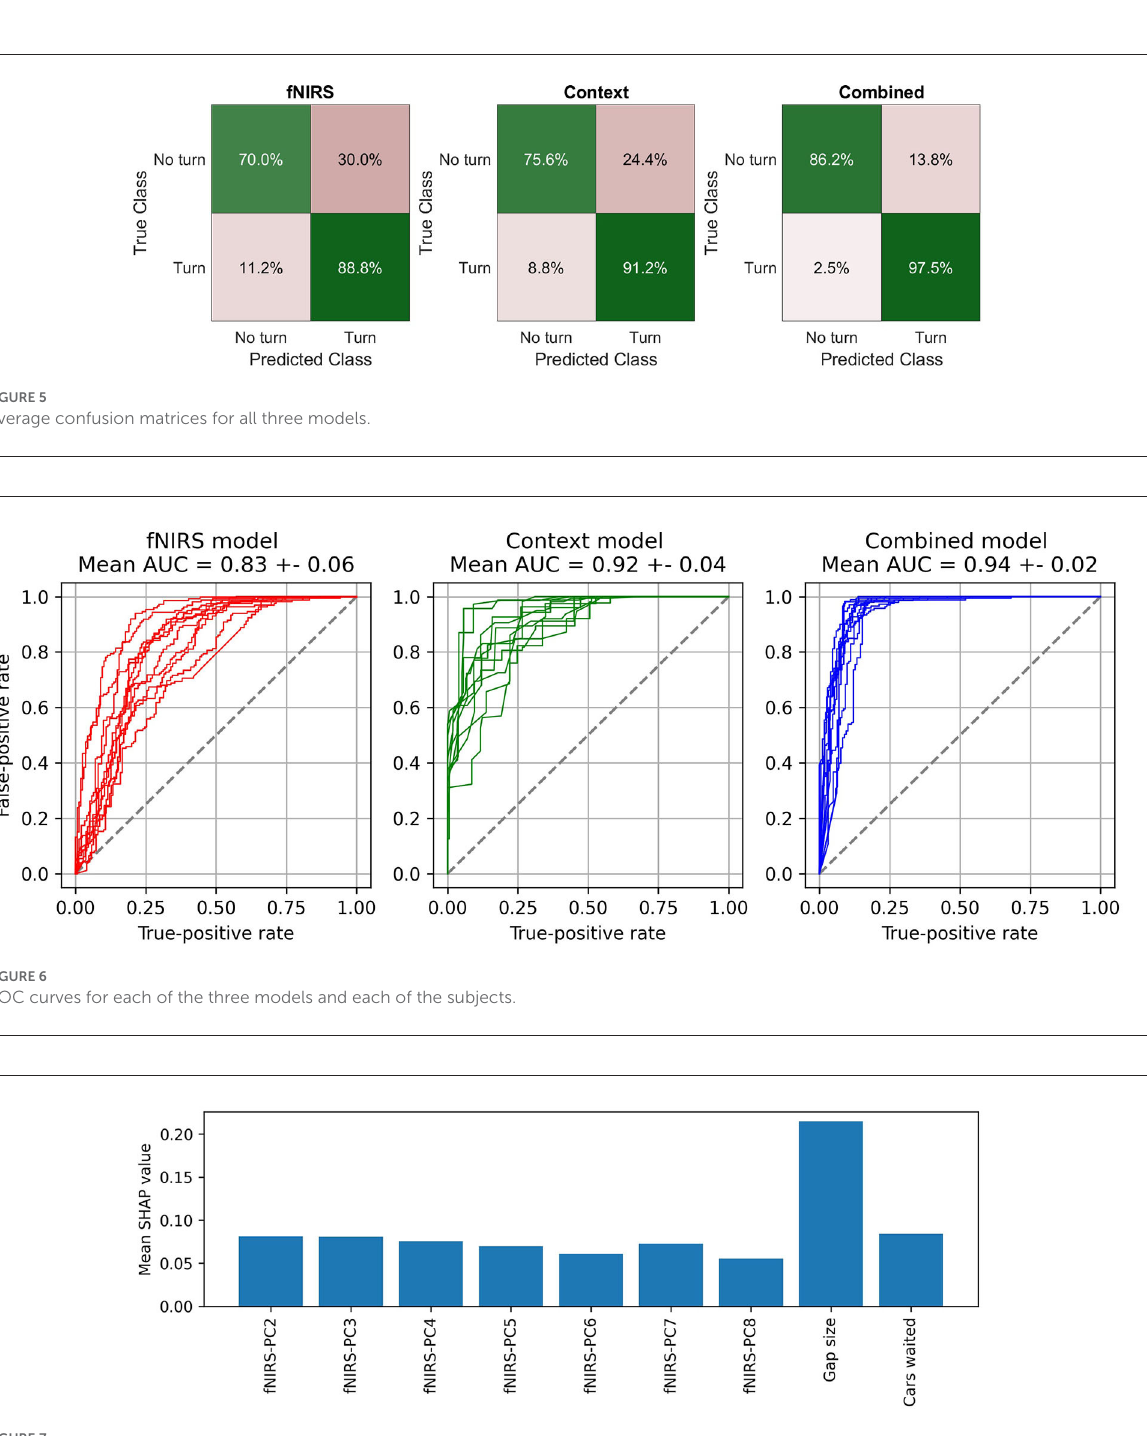
only 2.5%. Figure 6 shows the receiver operating characteristic (ROC) curves for the three models and one curve per subject. The corresponding average area-under-curve (AUC) and the standard deviation are shown in the title. The combined model